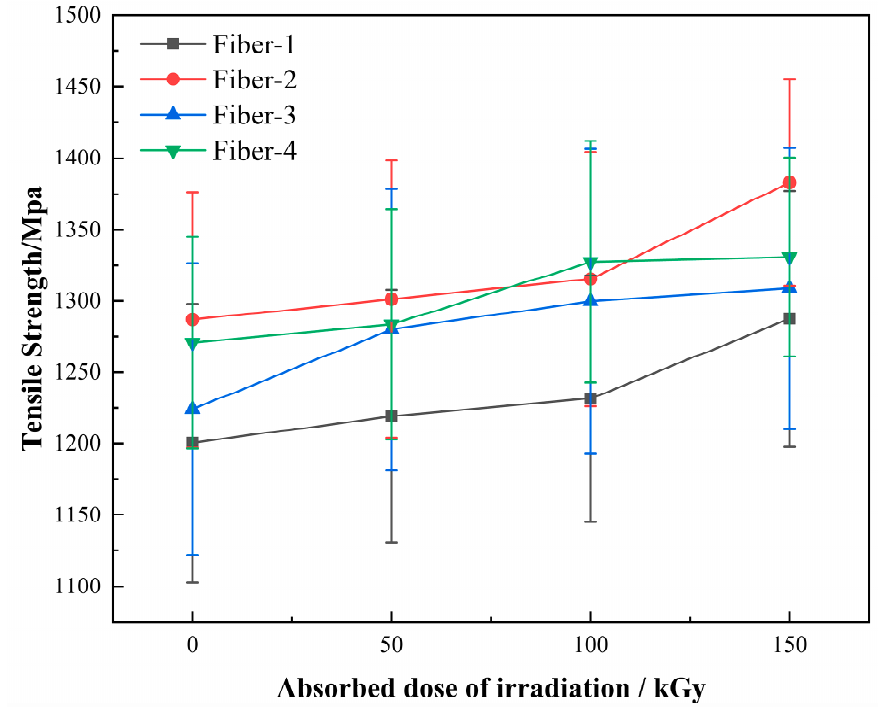
Figure 12. Variation of fiber tensile strength with the gamma irradiation absorbed dose.